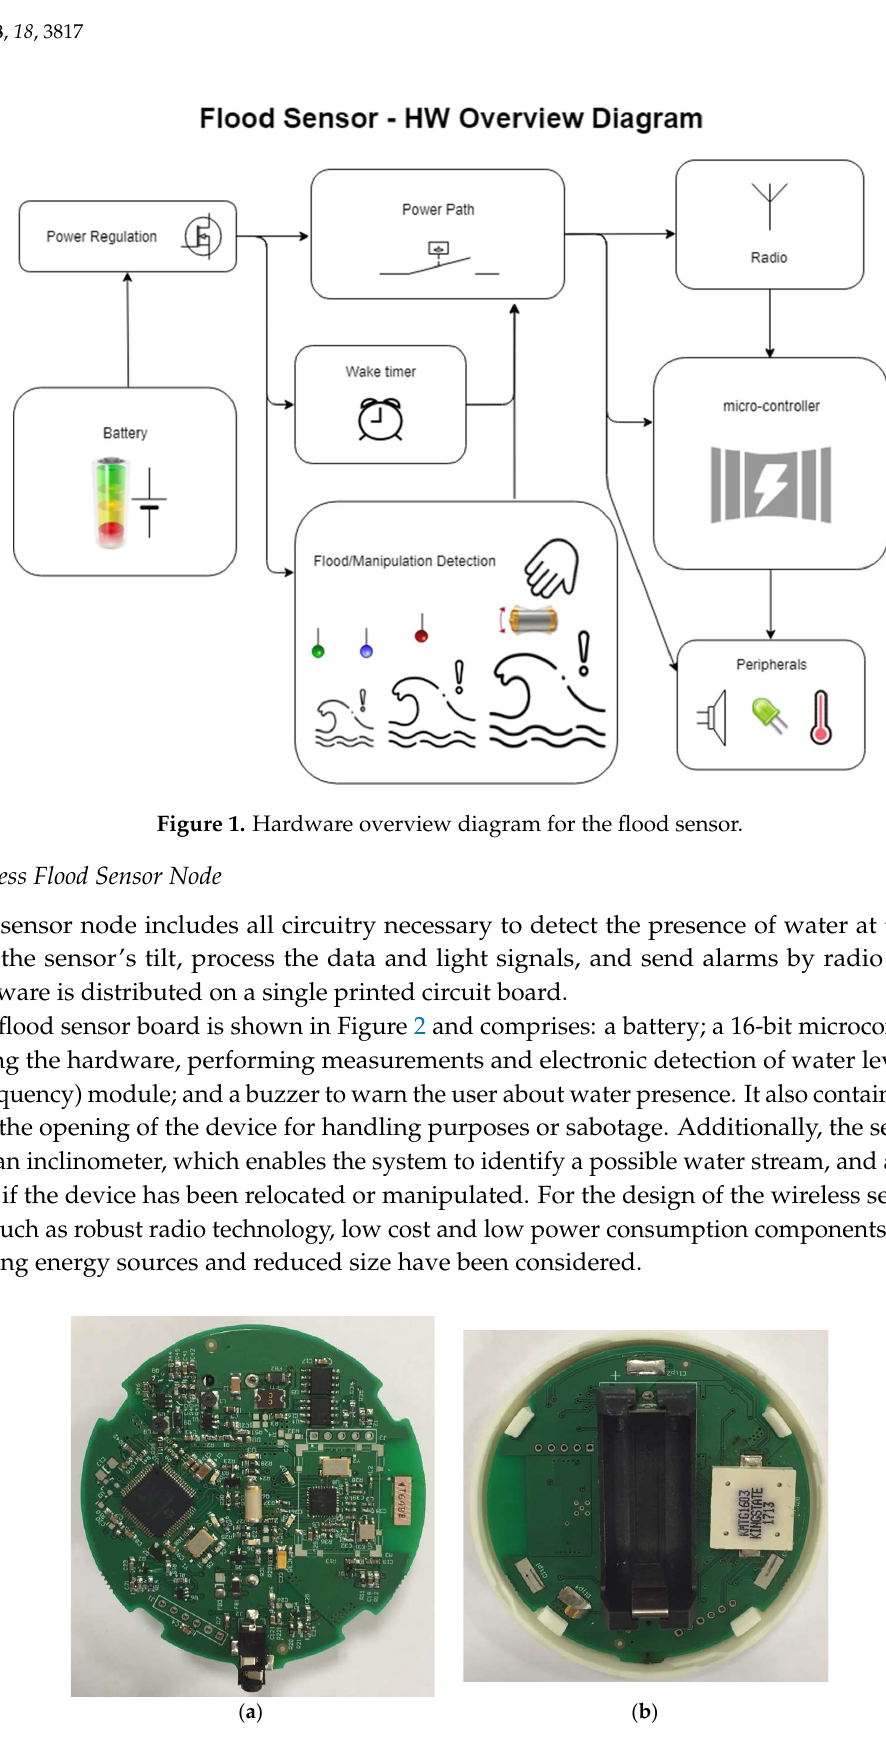
Figure 2. Wireless flood sensing node. ( a ) Top; ( b )